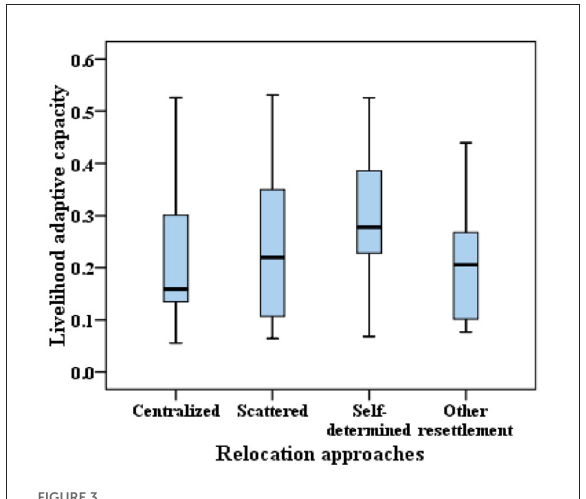
FIGURE3 The livelihood adaptive capacity index of different relocation